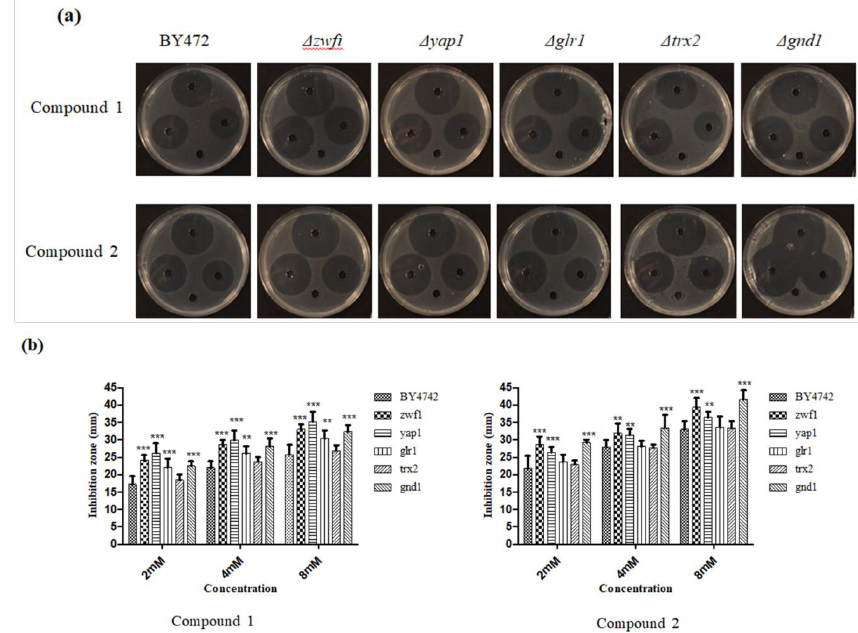
Figure 6. Plate inhibition zone assay showing the antifungal activity of two selenocyanates against yeast wt and mutants. ( a ) The representative pictures of inhibition zones of yeast mutants and wt (BY4742). Cells were incorporated into 50 °C warm agar and poured into a Petri plate. The upper well contained 20 μL of 8 mM solution, the hole at the left side of each P etri dish contained 20 μL of 4 mM solution and the hole at the right side of the Petri dish contained 20 μL of 2 mM solution of each compound tested. The lower hole contained 20 μL of 5 % DMSO . ( b ) The diameter of inhibition zone was measured. Error bars show standard deviation about the mean, n = 9. Values represent means ± S.D. ** p < 0.01 and *** p <